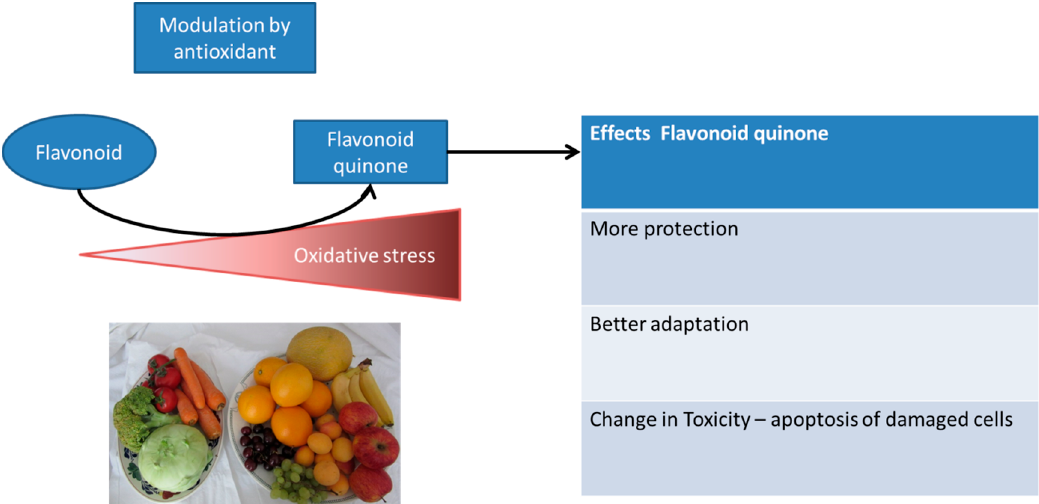
Figure 3. Example of exposure with a flavonoid that only induces different levels of redox adaptation in time in its oxidized form (flavonoid quinone). The more oxidative stress that is present, the more flavonoid scavenges the present ROS and the more flavonoid quinone is formed.